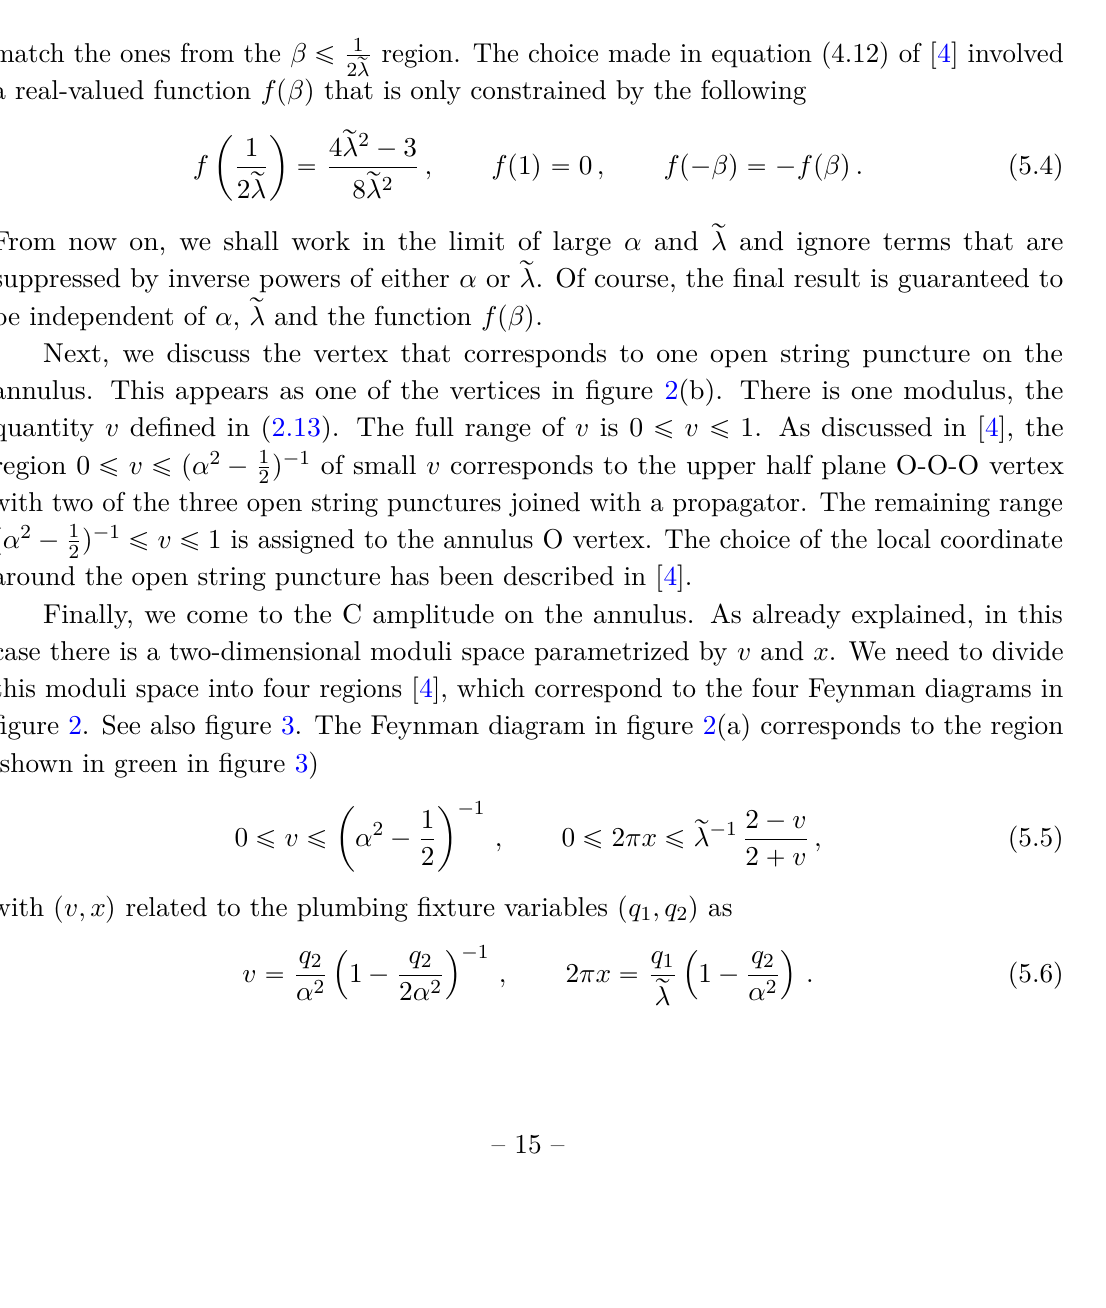
r λ 3 (cid:1) 3 r λ r λ (cid:16) 4 , α (cid:16) 2 and f p β q (cid:16) 4 β p 1 (cid:1) β 2 q 4 r λ 2 (cid:1) 1